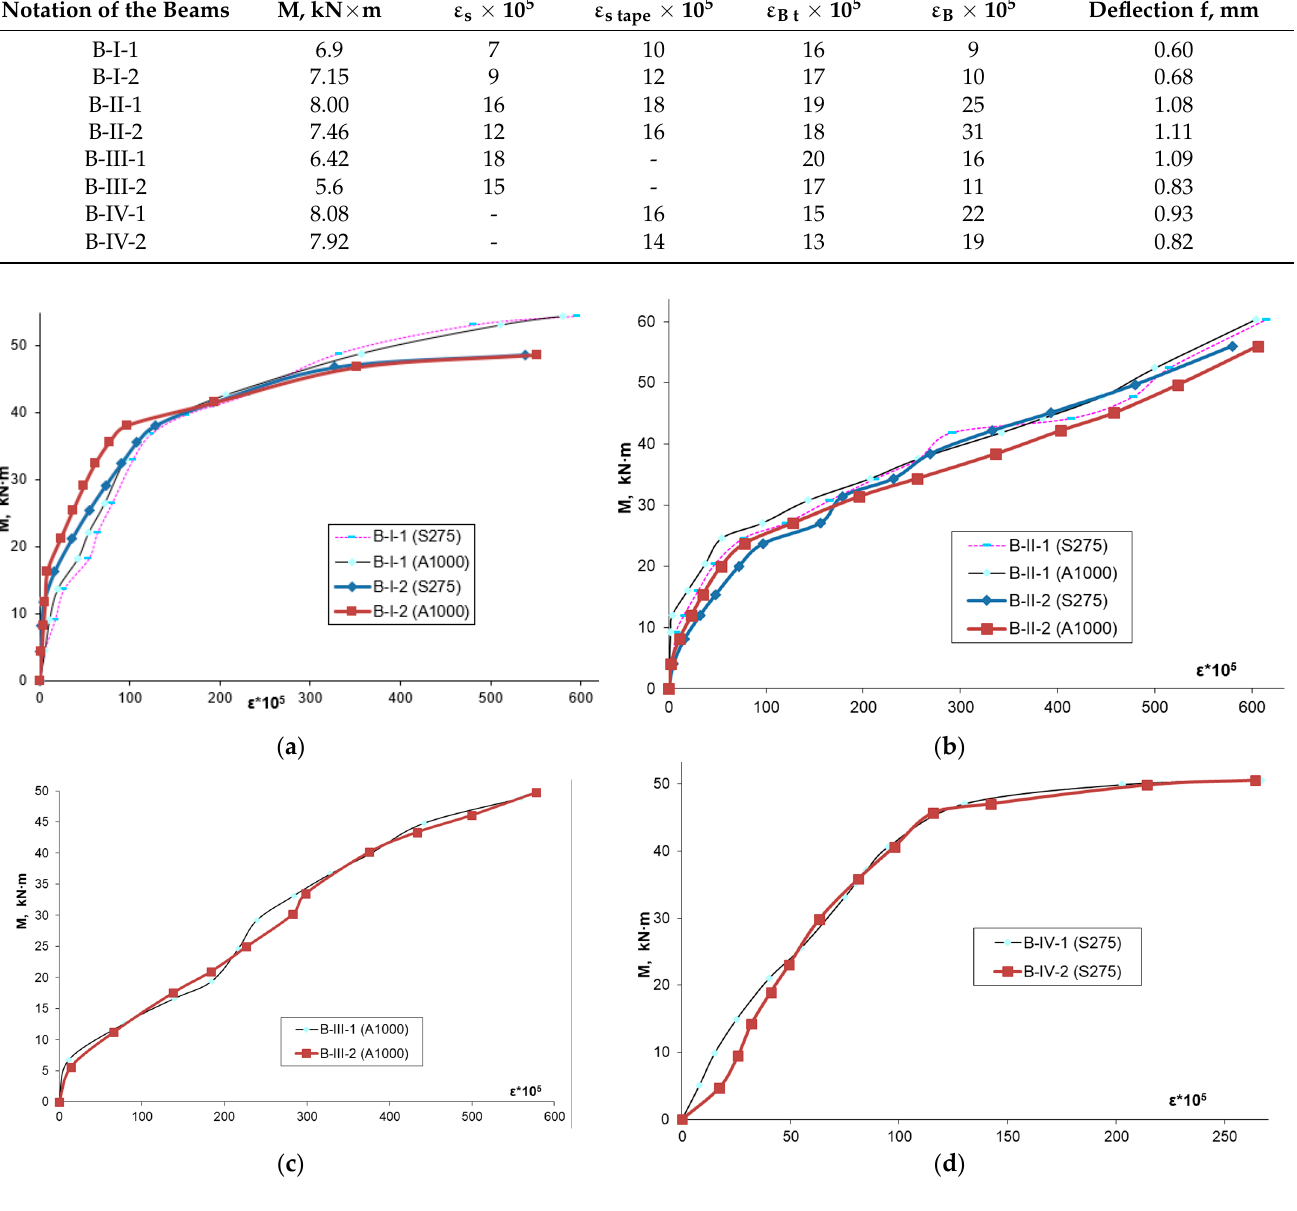
Figure 6. Graphs of strain development: ( a ) the development of strains in stretched rebars for series B-I; ( b ) the same for series B-II; ( c ) the same for series B-III; ( d ) the same for series B-IV; Y-axis indicates experimental values of bending moment M (kNm); X-axis indicates the corresponding strain values ε × 10 5 .